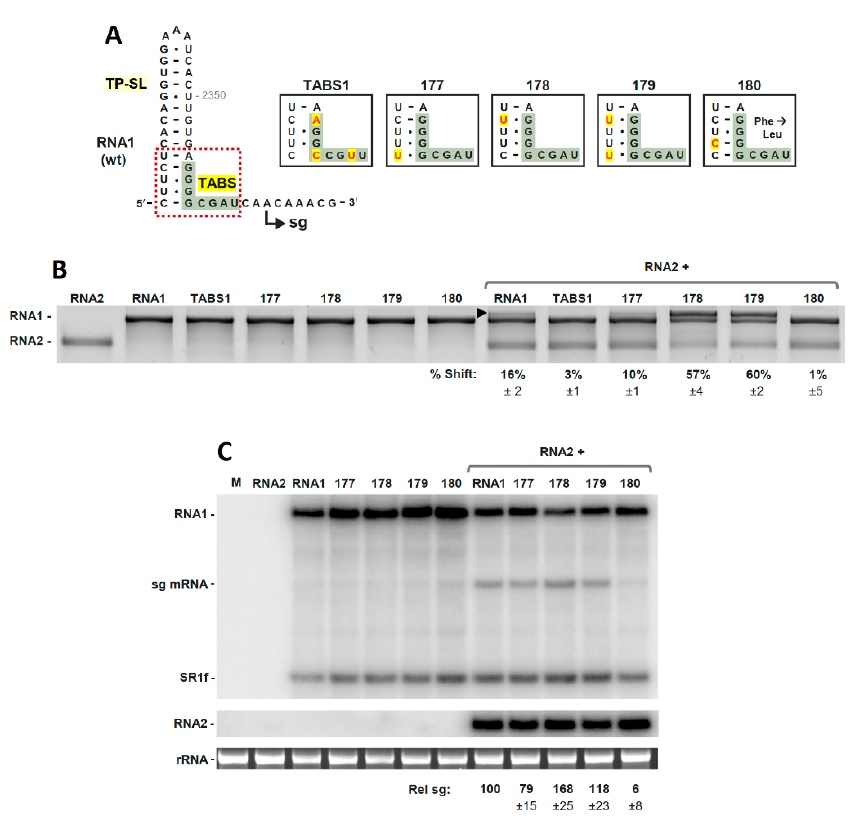
Figure 3. Mutational analysis of the TP-SL/TABS pairing in RCNMV RNA1. ( A ) Wild-type RCNMV RNA1 and mutants with nucleotide substitutions depicted in red with yellow highlighting. ( B ) RNA–RNA electrophoretic mobility shift assay of wt RNA1 and RNA1 mutants with wt RNA2 performed in 3% agarose gels stained with ethidium bromide. The position of RNA1–RNA2 complexes is indicted by an arrowhead. The contents of each lane are indicated above the gel and the percentages for shifted RNA1 are shown with SEM (n = 3). ( C ) Northern blot analysis of plus-strand genome accumulation from wt RNA1 and mutants transfected alone or with RNA2. RNA was isolated from protoplasts 22 h post transfection. The contents of each lane are indicated above the blot. The positions of the RNA1 and RNA2 genome segments, the subgenomic mRNA, and a stable degradation product of RNA1 (SR1f) are indicated on the left. Loading controls (rRNA) are also shown. In each coinfection, the level of sg mRNA accumulation was calculated relative to the accumulation level of its cognate RNA1. The relative levels of sg mRNA (Rel sg) and RNA2 (Rel RNA2) are shown below with SEM (n = 3).